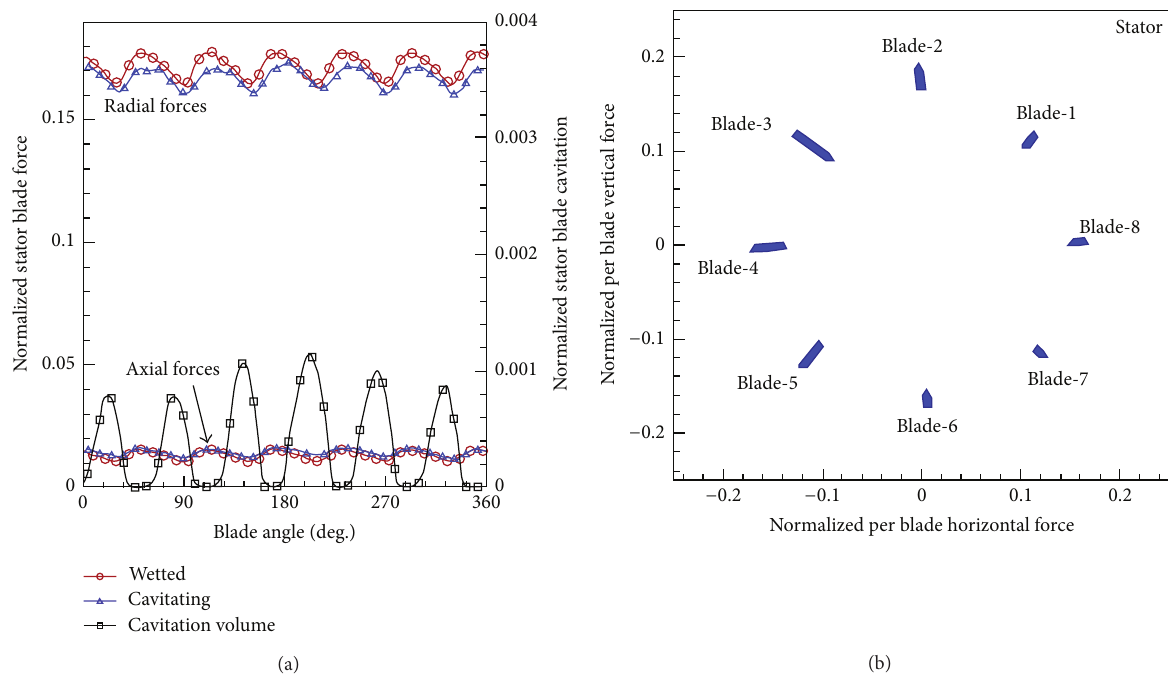
Figure 17: Normalized unsteady wetted and cavitating axial forces and radial forces, and the normalized fluid cavitation volume, on a stator blade along one revolution in ship-fixed coordinates with blade angular positions referring to the referenced rotor blade (a) and per blade horizontal and vertical side forces for all eight stator blades in ship-fixed coordinates